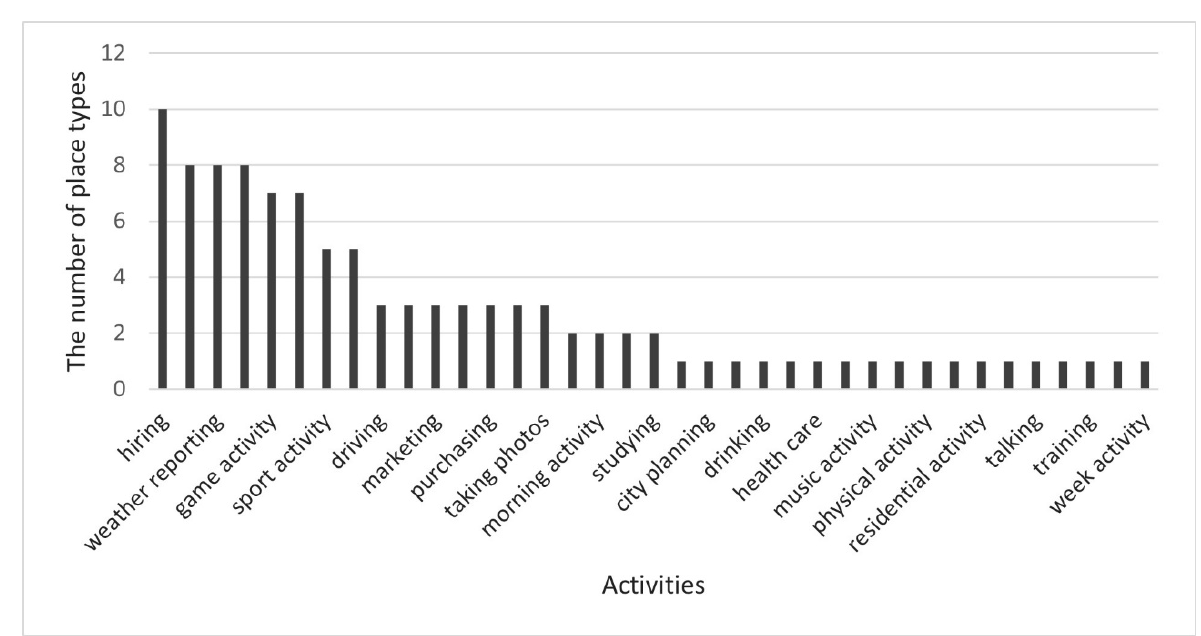
Figure 5. Multiplicity of place types vs. activity types.